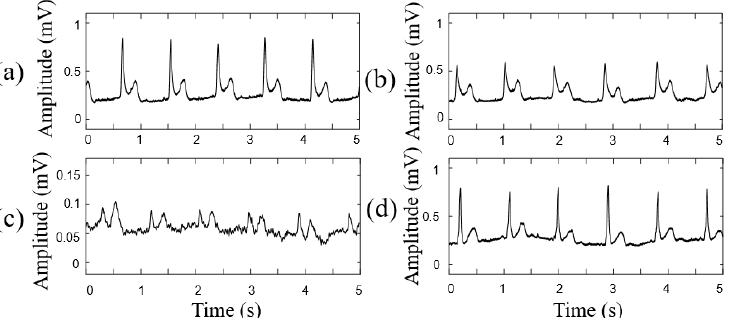
Figure 10. ECG signals acquired by smart clothing across the different thicknesses and materials: ( a ) 100% cotton, 0.35 mm, ( b ) 100% cotton, 0.7 mm, ( c ) 93% polyester, 0.31 mm, and ( d ) 100% cotton, 0.35 mm (sweating condition).